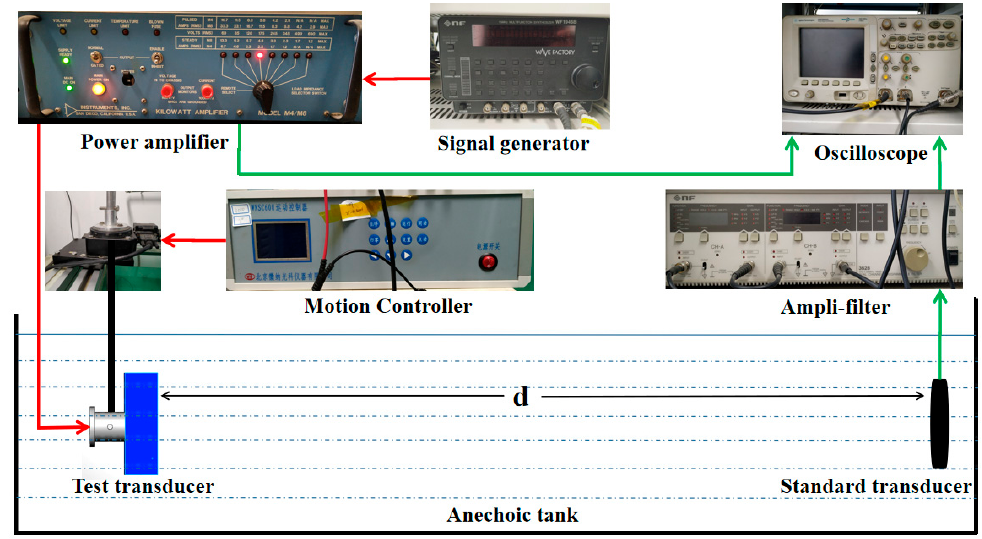
Figure 14. Test system for the transducer.